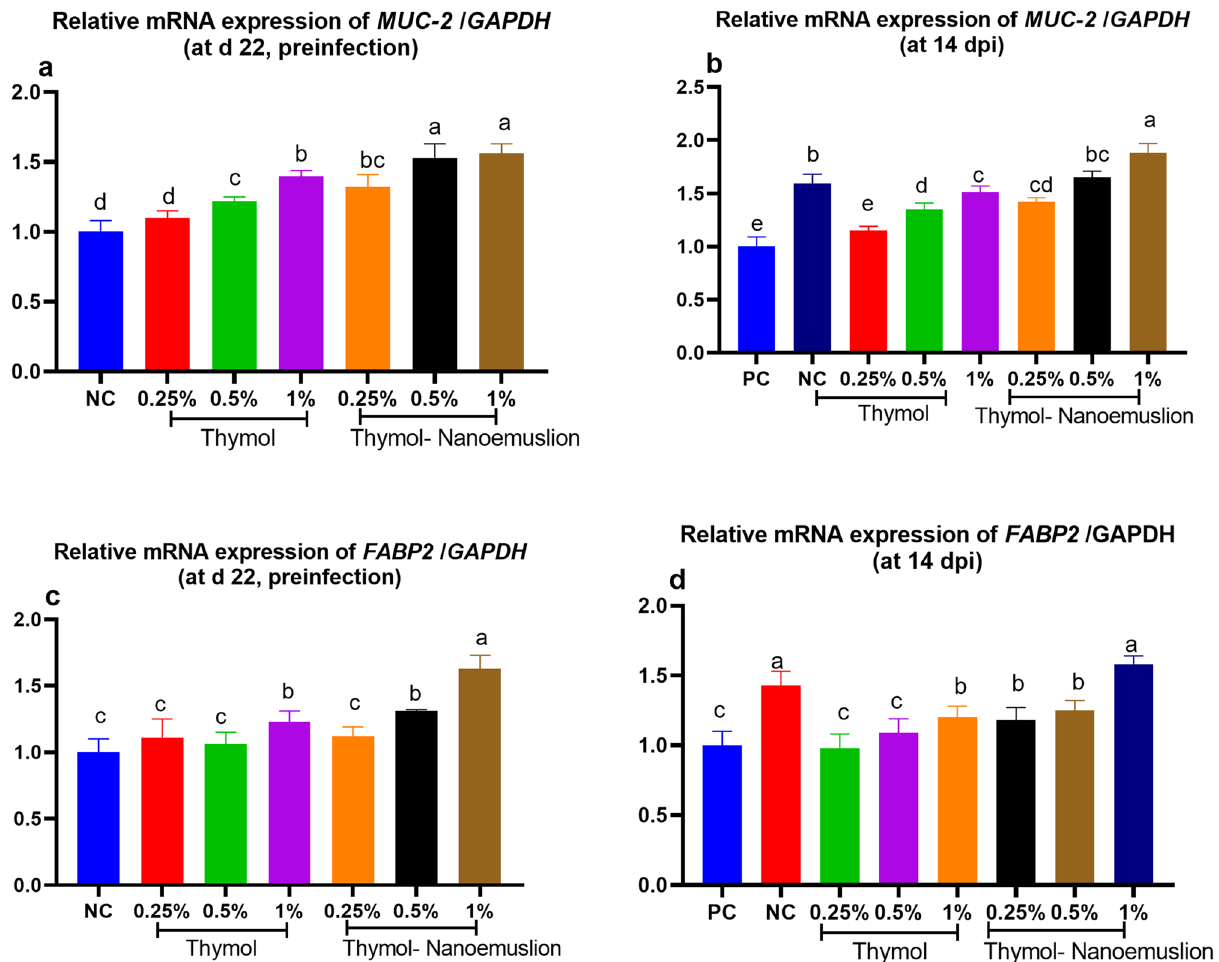
Figure 3. Relative mRNA expression levels of mucin-2 ( MUC -2; a , b ) and fatty acid binding proteins ( FABP2 ; ( c , d ) in the spleen of broilers fed different levels of thymol and thymol nanoemulsion preinfection (d 22) and 14 days postinfection (14 dpi) with S. Typhimurium. Error bars represent SEM. At d 22 preinfection: NC (negative control) = birds fed basal diet, thymol 0.25, 0.5 and 1% = birds fed basal diet supplemented with 0.25, 0.5 and 1% thymol, thymol nanoemulsion 0.25, 0.5 and 1% = birds fed basal diet supplemented with 0.25, 0.5 and 1% thymol nanoemulsion. At 14 dpi: NC (negative control): birds fed basal diet; PC (positive control): birds fed basal diet and challenged with S . Typhimurium at d 23 of age; thymol 0.25, 0.5 and 1%: birds fed basal diet supplemented with 0.25, 0.5 and 1% thymol; thymol nanoemulsion 0.25, 0.5 and 1%: birds fed basal diet supplemented with 0.25, 0.5 and 1% thymol nanoemulsion. All groups except NC group were challenged with S . Typhimurium at d 23 of age. a–e Means within the same column carrying different superscripts are significantly different at p <